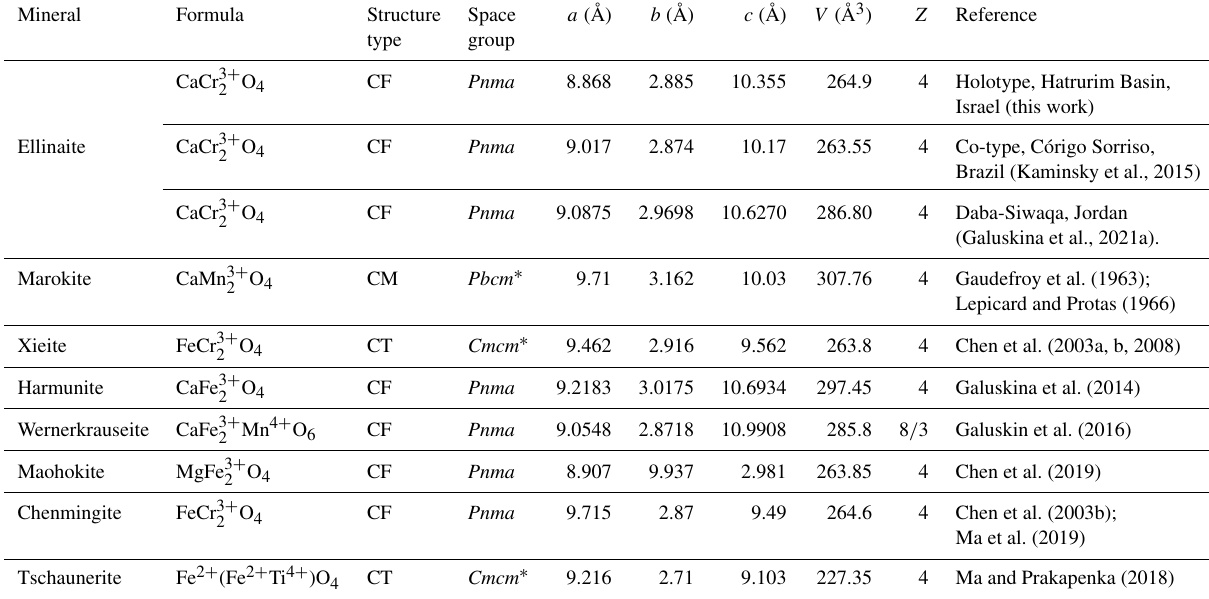
Table 7. Comparative crystallographic data for ellinaite and related post-spinel minerals. Mineral Formula Structure